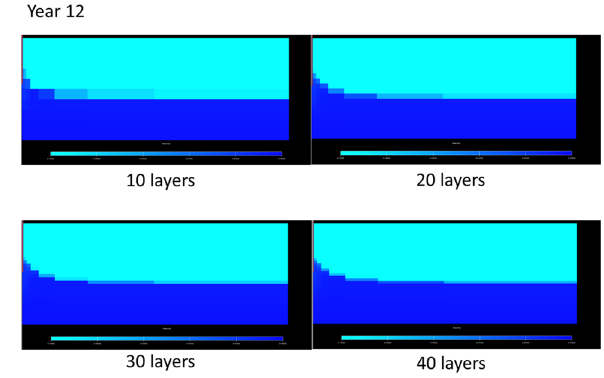
Fig. 14 Water saturation profile along a reservoir radius for 4 models with different layers after 12-year